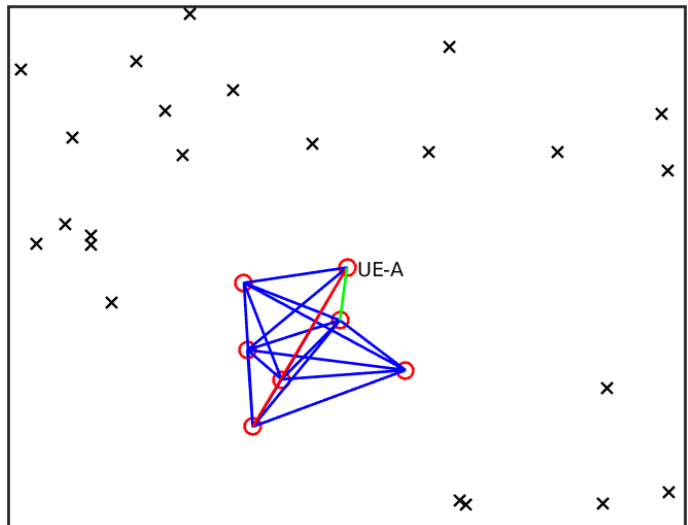
Figure 5. Example VPMN layout. Red circles: UEs of the VPMN. Crosses: other UEs. Green line: minimum distance between UE-A and any other UE in the VPMN. Red line: maximum distance between UE-A and any other UE in the VPMN.